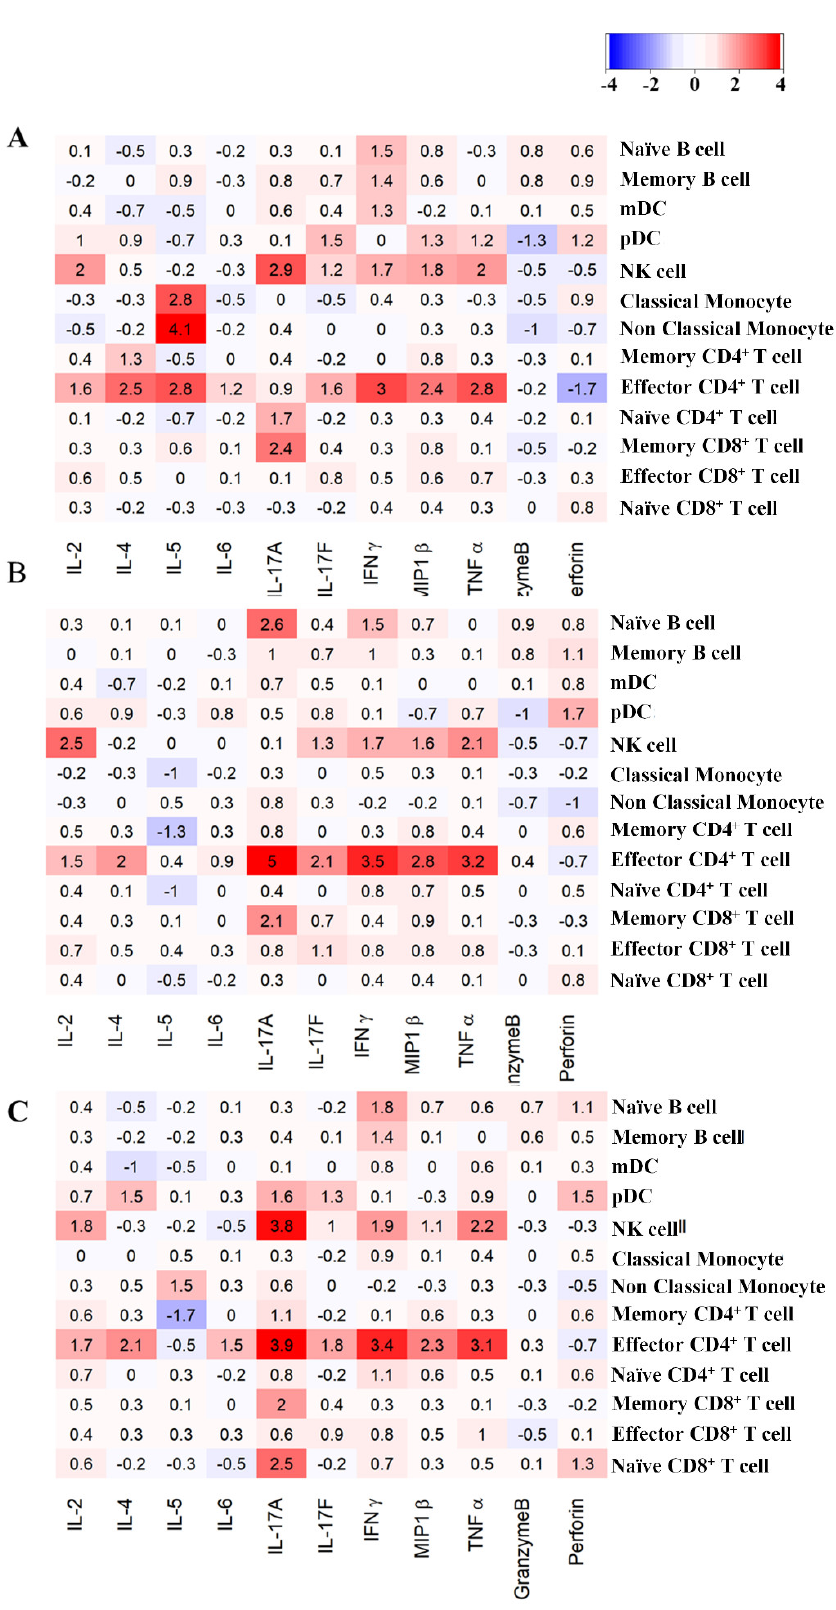
Figure 6. The intracellular cytokine-mediated expression. The heat map represents log 2 -fold expression of intracellular cytokines of different immune cell types when exposed to ( A ) PVP Ag 10 ( B ) PVP Ag 20 , and ( C ) PVP Ag 40 .